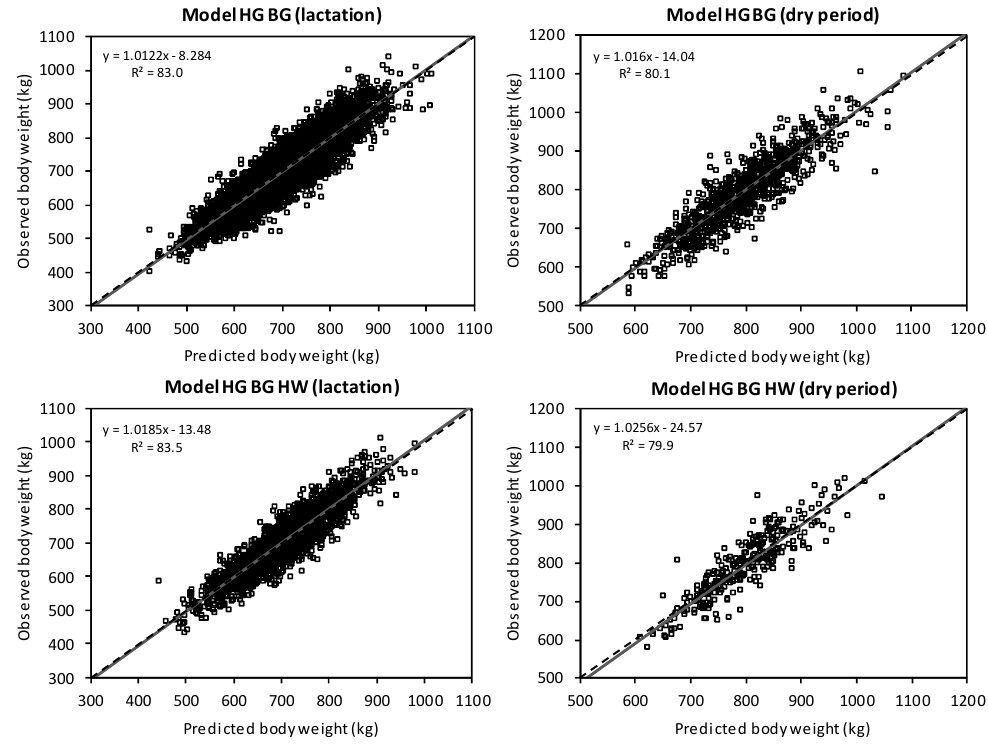
Figure 3. Linear regression of observed on predicted body weight with original values within the prediction equations Model HG BG and Model HG BG HW (HG: heart girth; BG: belly girth; HW: hip width). If the error of central tendency and regression is 0, then the intercept is 0, the slope is 1, and the regression is identical to the dashed